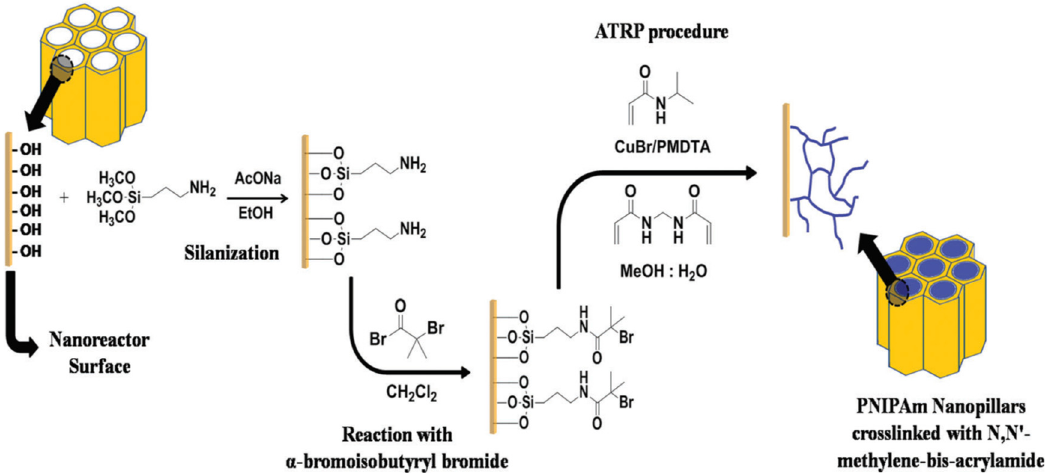
Figure 12. Scheme of synthesis of PNIPAm-AAm nanopillars [74]. Copyright 2017. Reproduced with permission from the publisher: RSC.